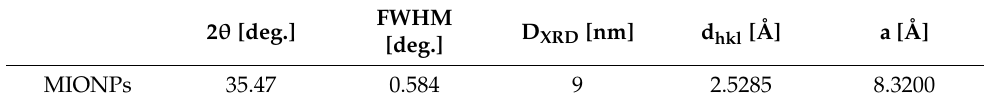
Table 1. Structural parameters of XRD analysis for the most intense peak (311). 2 θ